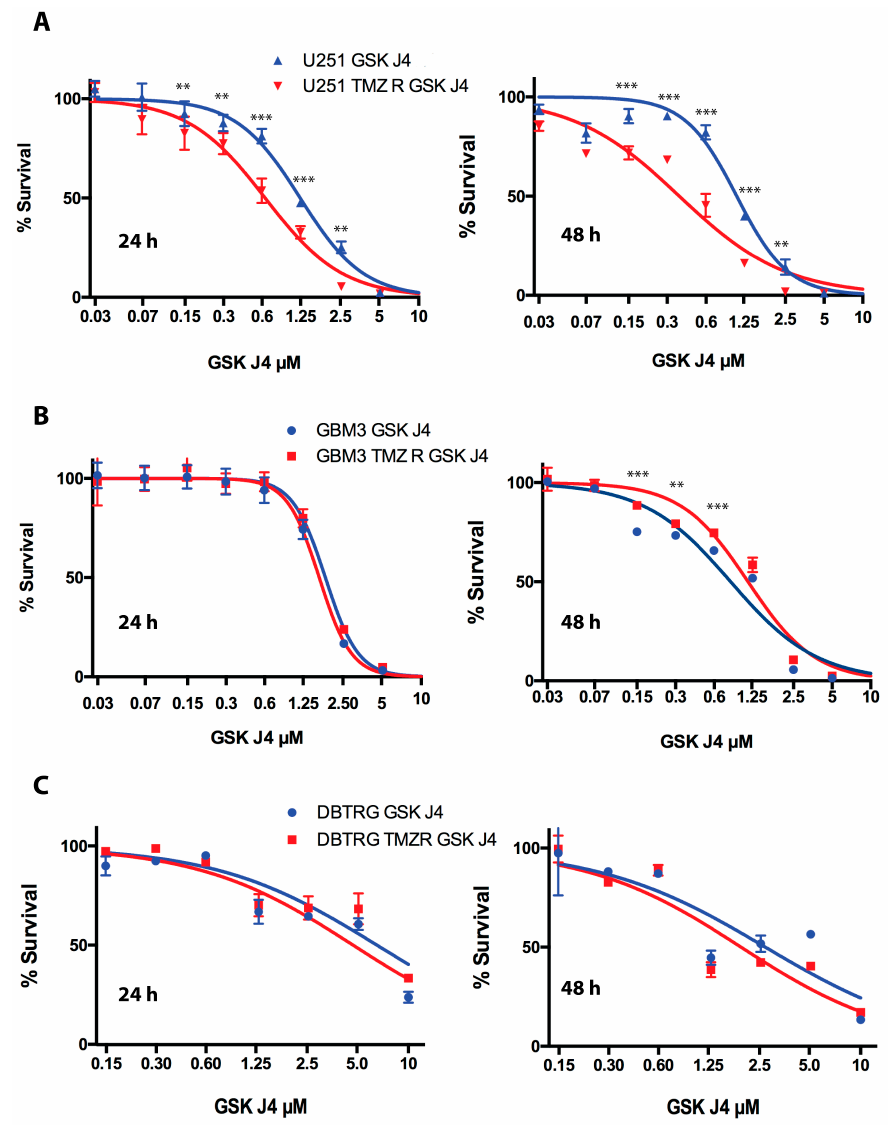
Figure 2. Effect of GSK J4 on cell proliferation. Native and temozolomide (TMZ) resistant U251 ( A ), GBM3 ( B ), and DBTRG ( C ) glioblastoma cells were analyzed in parallel by MTS after 24 and 48 h of treatment with GSK J4 at different concentrations. Statistical analysis was performed by ANOVA, applying Bonferroni post-hoc correction. p -values: ** = 0.01; *** = 0.001; no asterisk indicates that the difference was not significant.